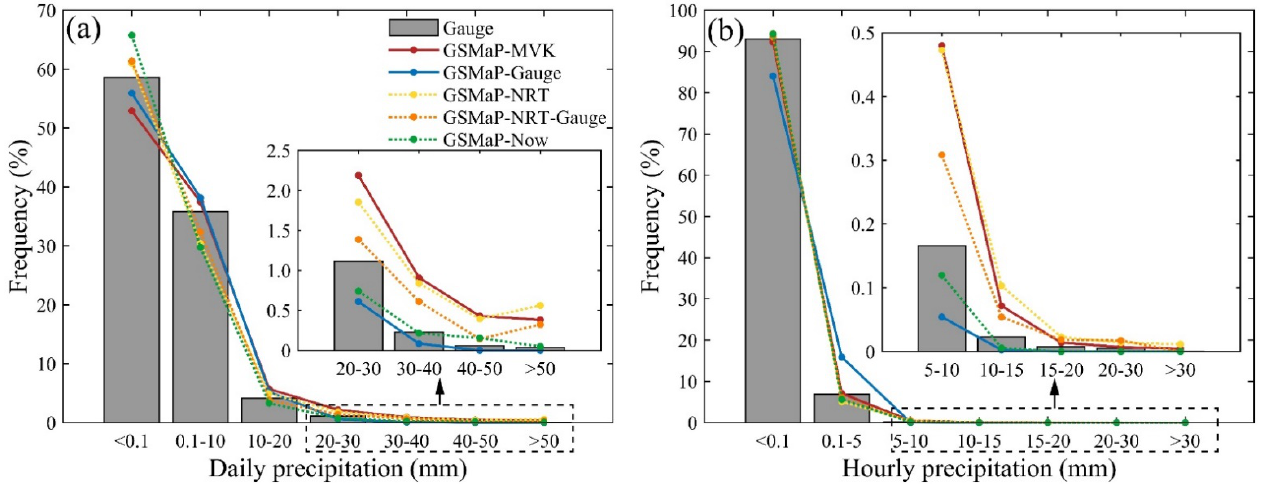
Figure 4. Histograms of the five GSMaP satellite precipitation estimates at thirteen stations in YRSR in comparison with the ground observations (29 March 2017–31 December 2018): ( a ) daily precipitation estimates and ( b ) hourly precipitation estimates.